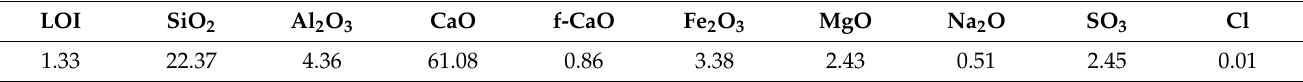
Table 1. Chemical composition of Portland cement (wt.%).